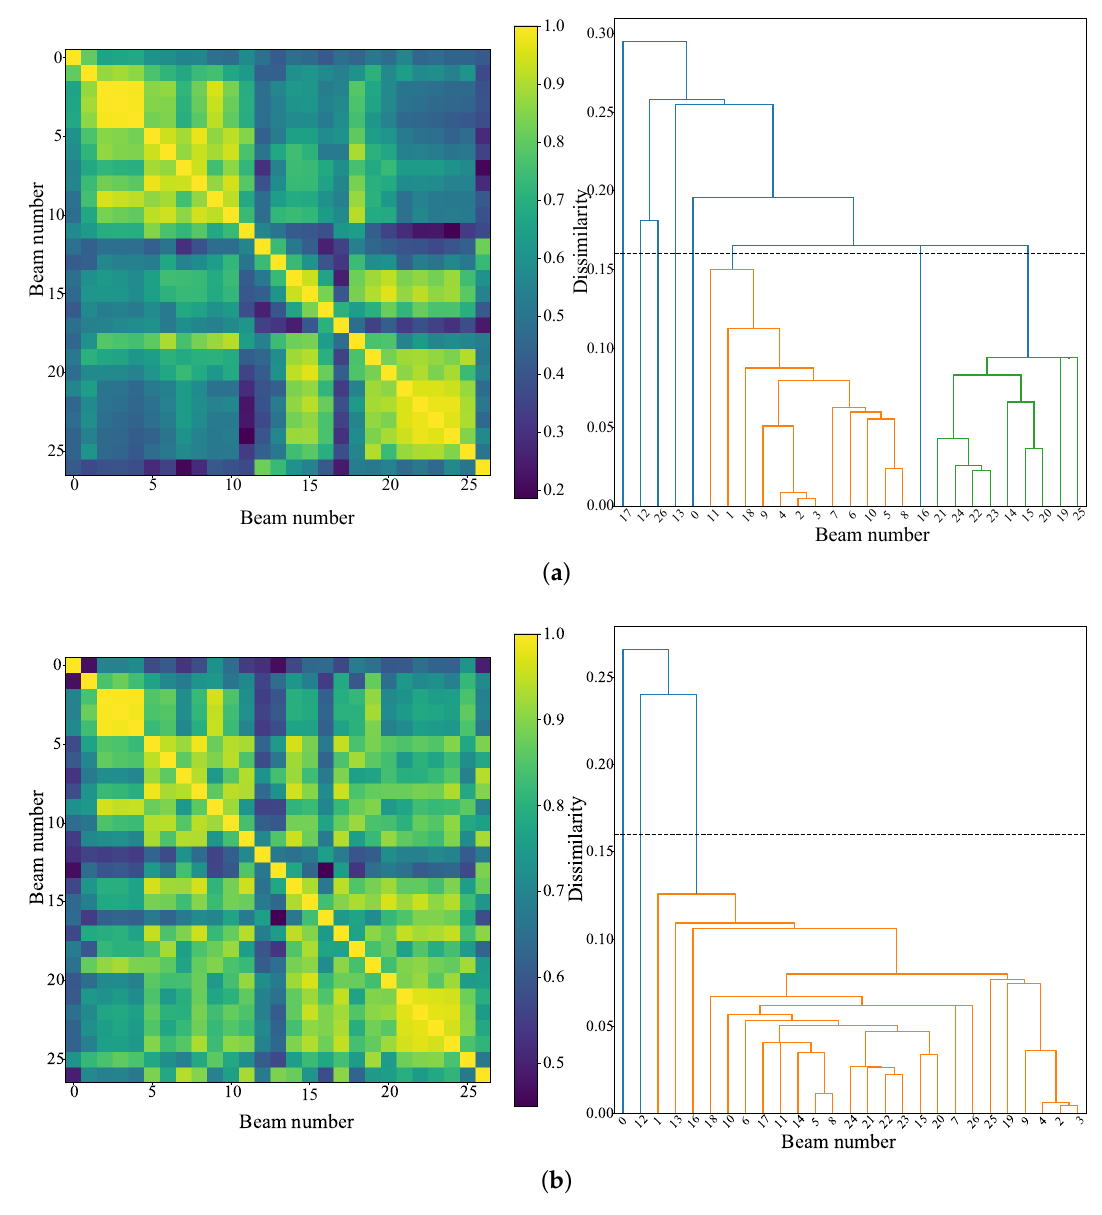
Figure 12. The similarity matrices and resulting dendrograms calculated from 27 stacked beams: ( a ) drawn before iteration and ( b ) drawn after iteration. The dissimilarity threshold is set to 0.16, and the branches with different colors represent different hierarchical